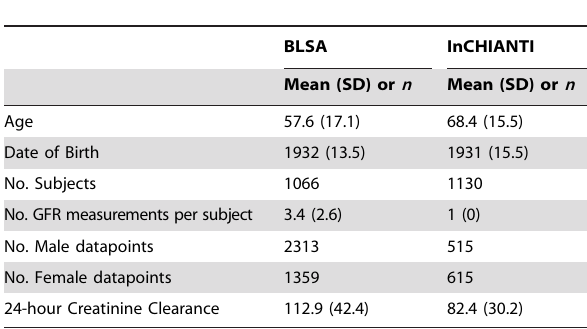
Table 1. Characteristics of kidney aging study samples.